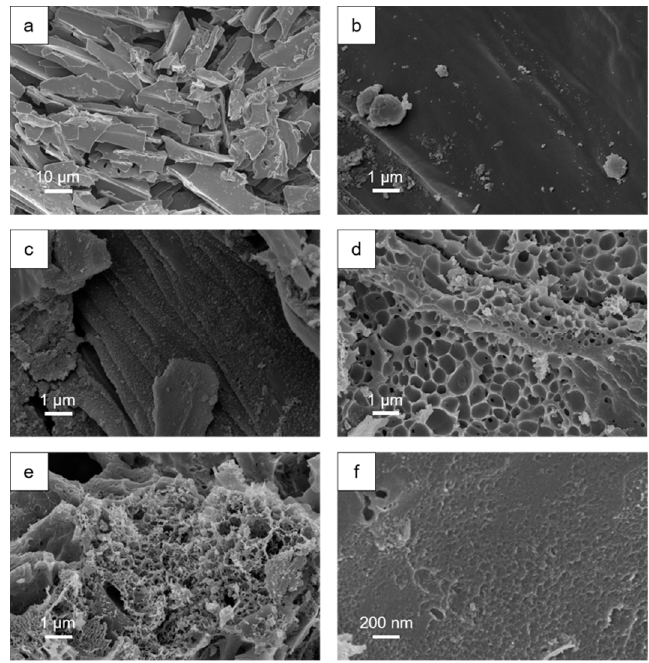
Figure 1. ( a ) SEM image of TC precursor; ( b ) SEM image of ATC-1 sample; ( c ) SEM image of ATC-2 sample; ( d ) SEM image of ATC-3 sample; ( e ) SEM image of ATC-4 sample; ( f ) high-magnification SEM image of ATC-3.